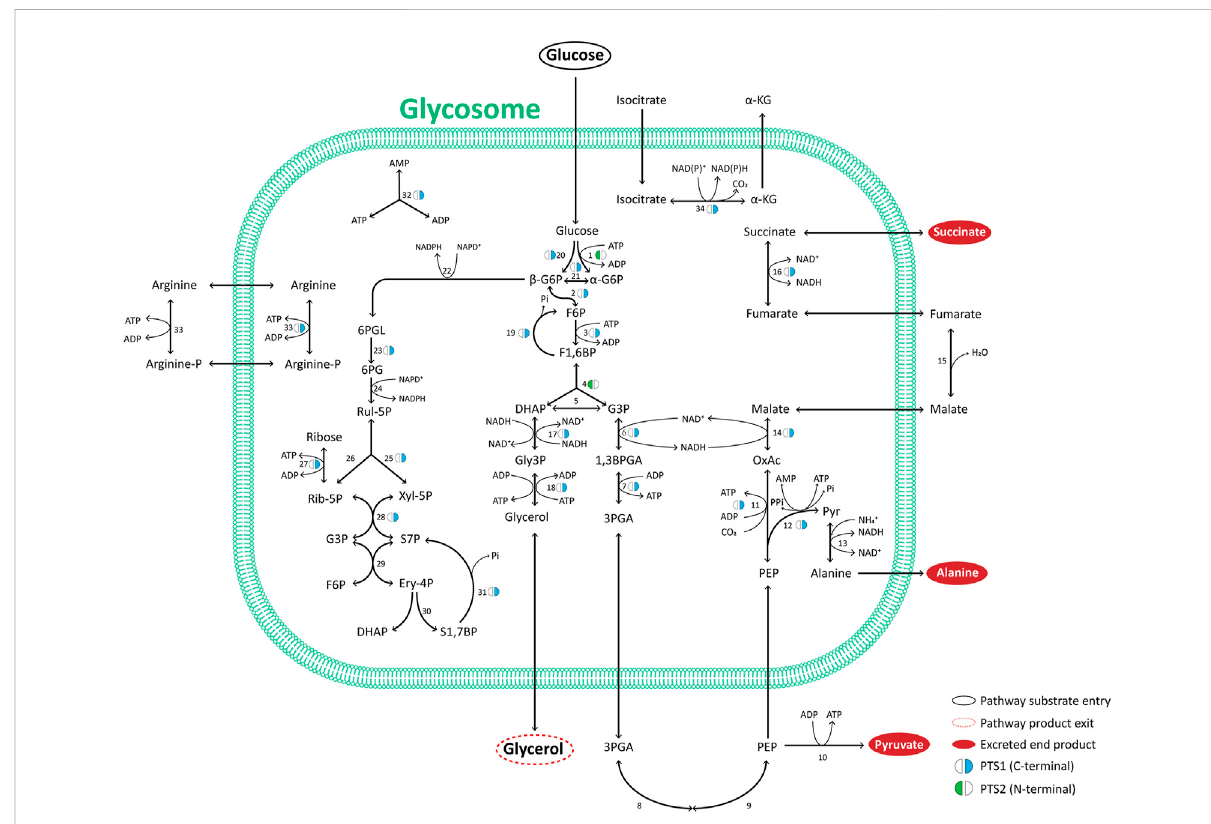
FIGURE 2 Major pathways of glycosomal carbon metabolism in TriTryps species. Indicated are enzymes of glycolysis, its auxiliary branches, gluconeogenesis, glycerol metabolism and thepentose-phosphate pathway. Notethat not all enzymes indicated are presentin each of the TriTryps species or expressed in each of their life-cycle stages. Enzymes: 1 . Hexokinase; 2 . Glucose-6-phosphate isomerase; 3 . Phosphofructokinase; 4 . Aldolase; 5 . Triose-phosphate isomerase; 6 . Glyceraldehyde-3-phosphate dehydrogenase; 7 . Phosphoglycerate kinase; 8 . Phosphoglycerate mutase; 9 . Enolase; 10 . Pyruvate kinase; 11 . Phosphoenolpyruvate carboxykinase; 12 . Pyruvate phosphate dikinase; 13 . Alanine dehydrogenase; 14 . Malate dehydrogenase; 15 . Fumarate hydratase; 16 . NADH-dependent fumarate reductase; 17 . Glycerol-3-phosphate dehydrogenase; 18 . Glycerol kinase; 19 . Fructose-1,6-bisphosphatase; 20 . Glucokinase; 21 . D -Hexose-6-Phosphate-1-epimerase; 22 . Glucose-6-phosphate dehydrogenase; 23 . 6-Phosphogluconolactonase; 24 ; 6-Phosphogluconate dehydrogenase; 25 . Ribulose-5-phosphate epimerase; 26 . Ribulose-5-phosphate isomerase; 27 . Ribokinase; 28 . Transketolase; 29 . Transaldolase; 30. Sedoheptulose-1,7-phosphate transaldolase; 31 . Sedoheptulose-1,7- bisphosphatase; 32 . Adenylate kinase; 33 . Arginine kinase; 34 . Isocitrate dehydrogenase. The presence of a PTS1 or 2, the carbon sources used, and the excreted end products are